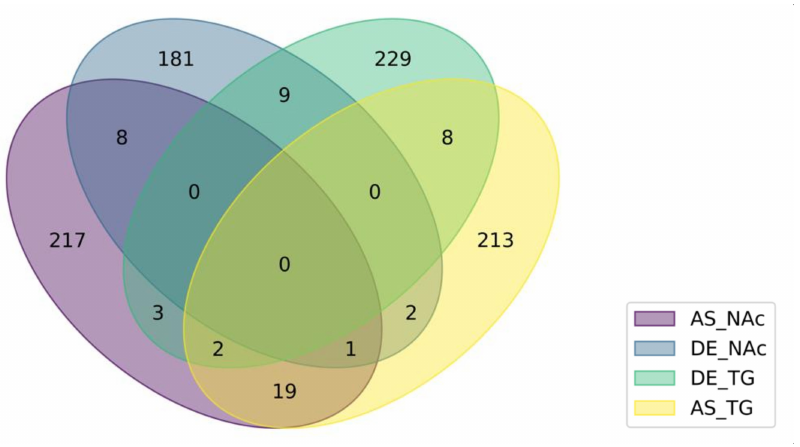
Figure 3. Number of genes presenting absolute (DE) or relative (AS) differential splicing action mode between opioid-induced hyperalgesia and control mice in the nucleus accumbens (NAc) or trigeminal ganglia